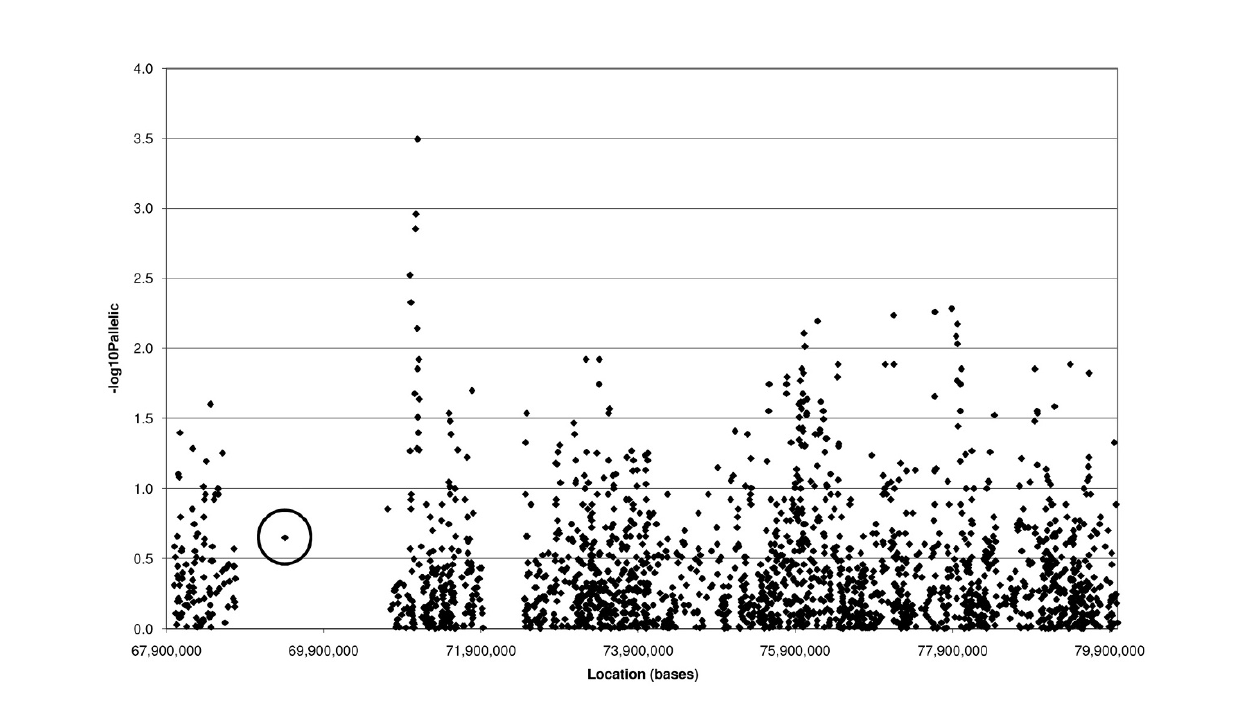
Figure 5 Associations between SNPs and the LCR polymorphism and colorectal cancer risk . -log association test ( χ 2 or Fisher's exact) for the CORGI colorectal tumour cases and controls are shown for each SNP by loca- tion, with the LCR copy number polymorphism, rs4916,